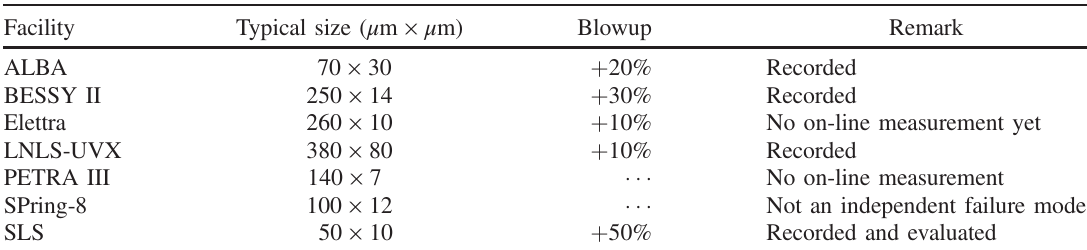
TABLE VI. Beam-blowup limits.